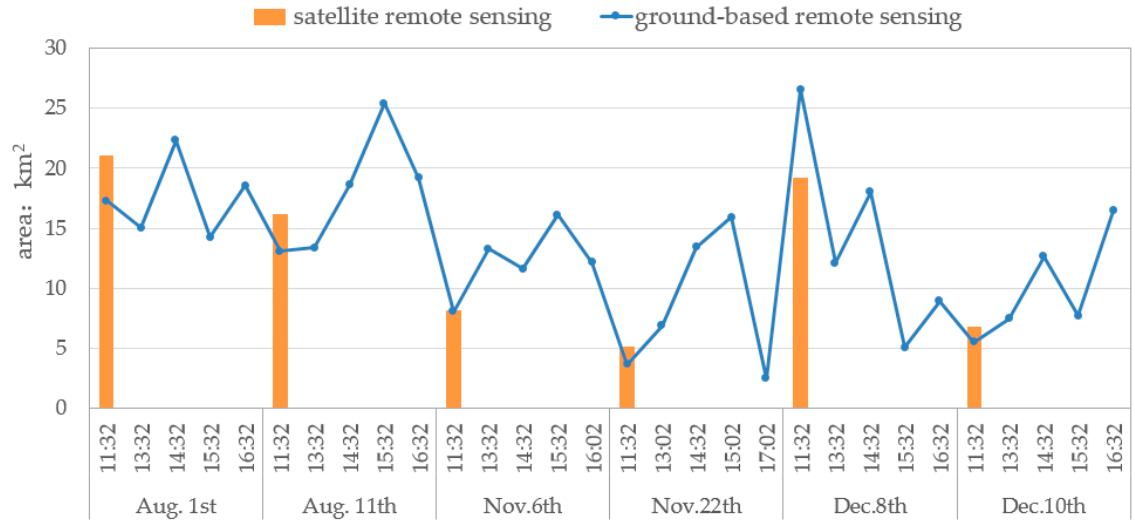
Figure 6. Comparison of the daily variation in cyanobacterial bloom areas as extracted by ground-based remote sensing and the results of synchronous satellite remote sensing on dates studied in 2019.